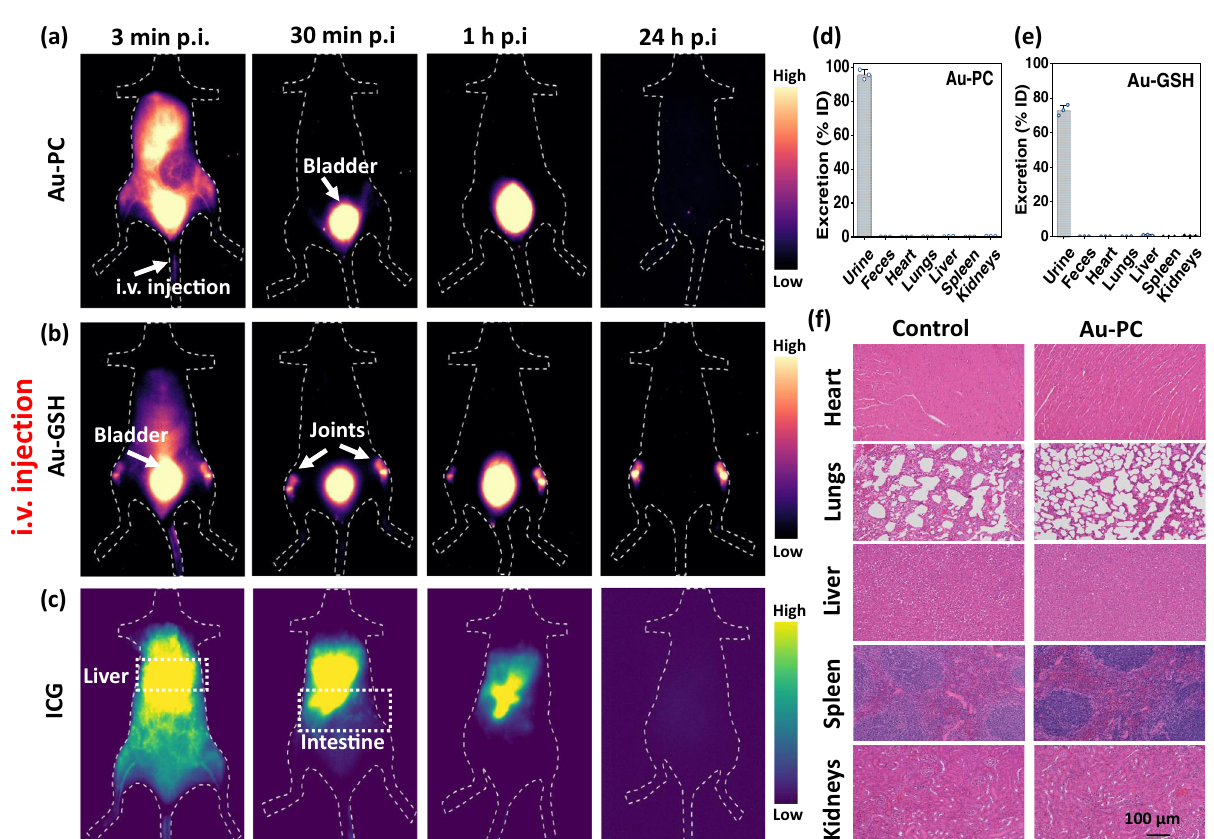
Fig. 2 | In vivo fl uorescence imaging with intravenous injected Au-PC, Au-GSH and ICG. Wide- fi eld NIR-II fl uorescence images (excited by an 808nm laser at a power density of 70mW/cm 2 , exposure times 40ms and 4ms for Au and ICG, respectively, 1100nm long pass fi lter) of intravenously (i.v.) injected a Au-PC con- jugate (4x, ~ 1.2mg), b Au-GSH cluster (4x, ~1.2mg) and ( c ) ICG (50 µ L, 50mM) probes at different time points (six to seven weeks old female Balb/c, n =